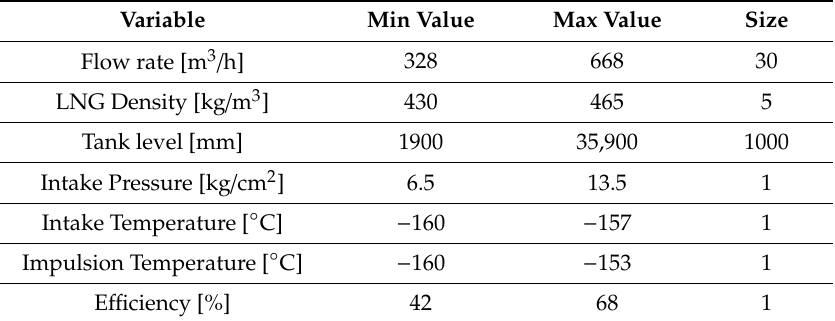
Table 8. List of variables, minimum values, maximum values and interval